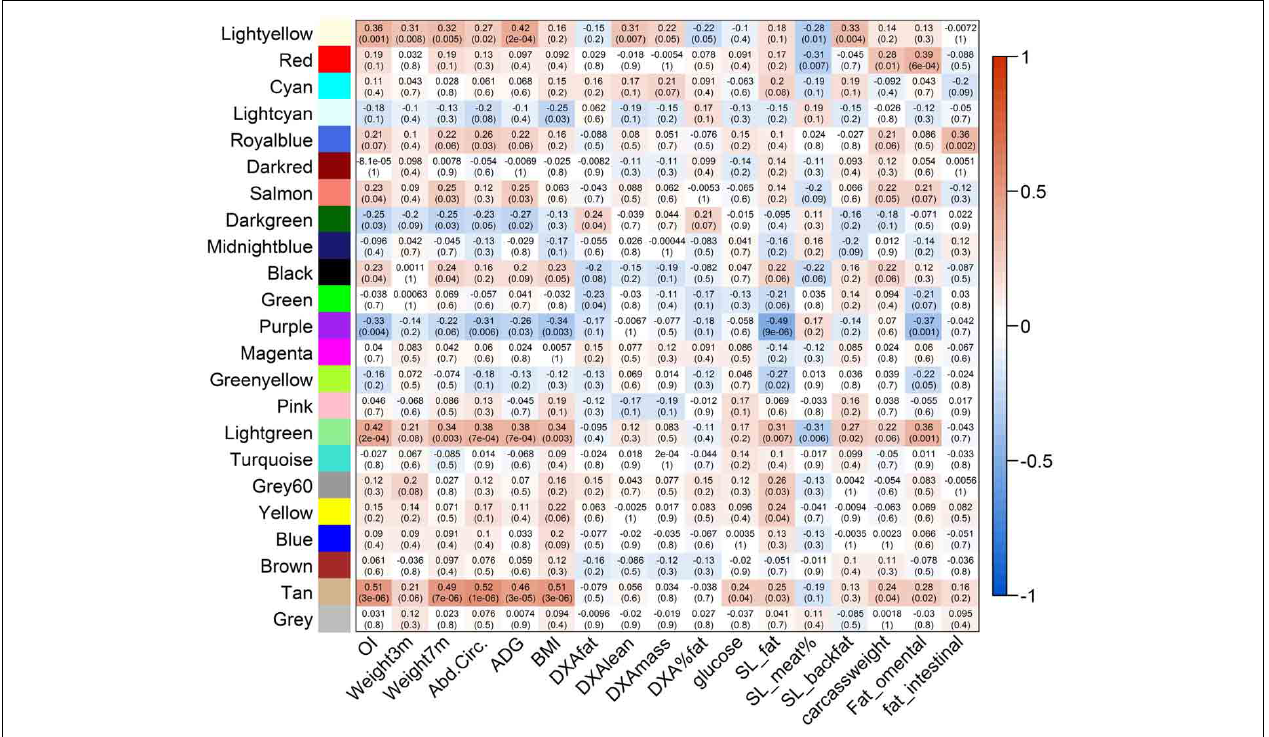
FIGURE 5 | Genome-wide Association Matrix (GMAT) of modules detected using the WISH network method. On the y-axis the detected modules are visualized, and on the x-axis the different phenotypes (OI and breeding values of 16 obesity-related phenotypes) are presented. In the